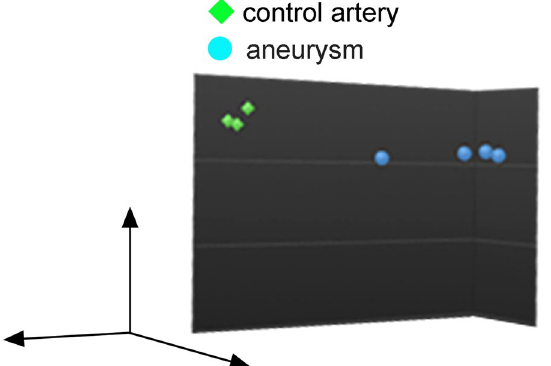
Figure 1. Principal component analysis of gene expressions in control arterial walls and intracranial aneurysms. Image from Principal component analysis of gene expressions in control arterial walls (n = 3) and intracranial aneurysms (n = 4) is shown, where genes expressed in primary culture of smooth muscle cells from human carotid artery were excluded.